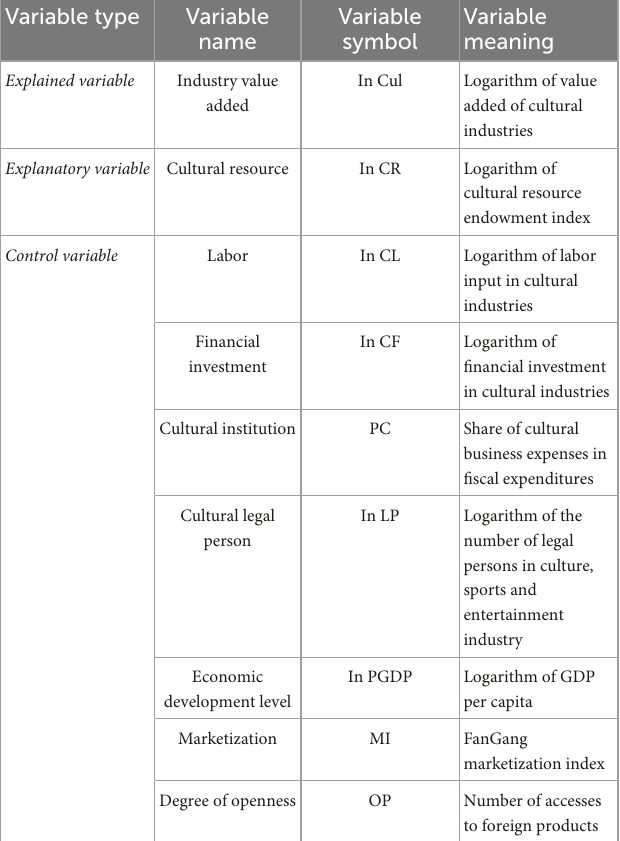
TABLE 3 Description of